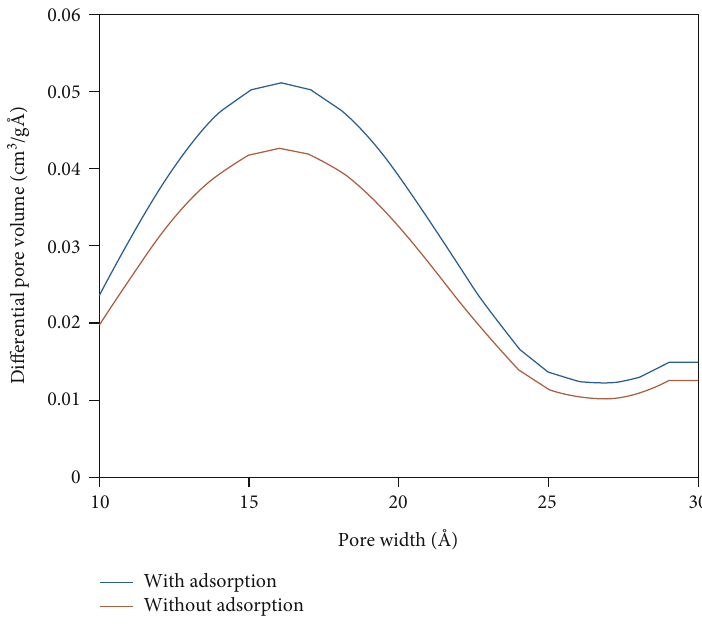
Figure 8: Pore size distribution plot of carbon nanotube.